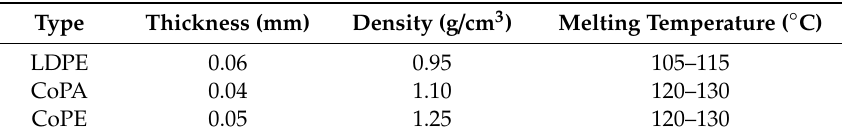
Table 1. Characteristics of the thermoplastic